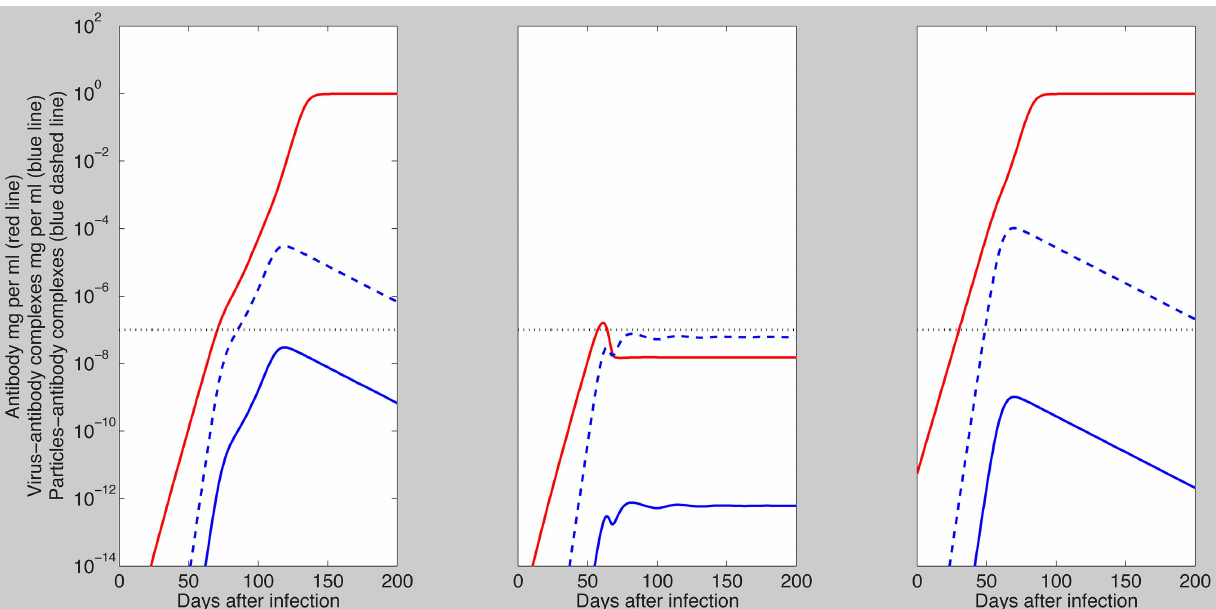
Figure 7. Free antibody (red lines), virus-antibody complexes (solid blue lines) and subviral particles-antibody complexes (dashed blue lines) in mg/ml as given by model (7) and parameters in Tables 1 and 2 (median values) for h ~ 10 3 , A 0 ~ 0 , r A ~ 0 : 358 d { 1 (left panel); h ~ 10 5 , A 0 ~ 0 mg/ml, r A ~ 0 : 358 d { 1 (middle panel); h ~ 10 5 , A 0 ~ 2 | 10 4 g mg/ml, r A ~ 0 : 358 d { 1 (right panel). The dotted black line represents the antibody limit of detection of 0 : 1 ng/ml and g ~ 2 : 7 | 10 { 16 is the factor transforming the units from molecules/ml to mg/ml.